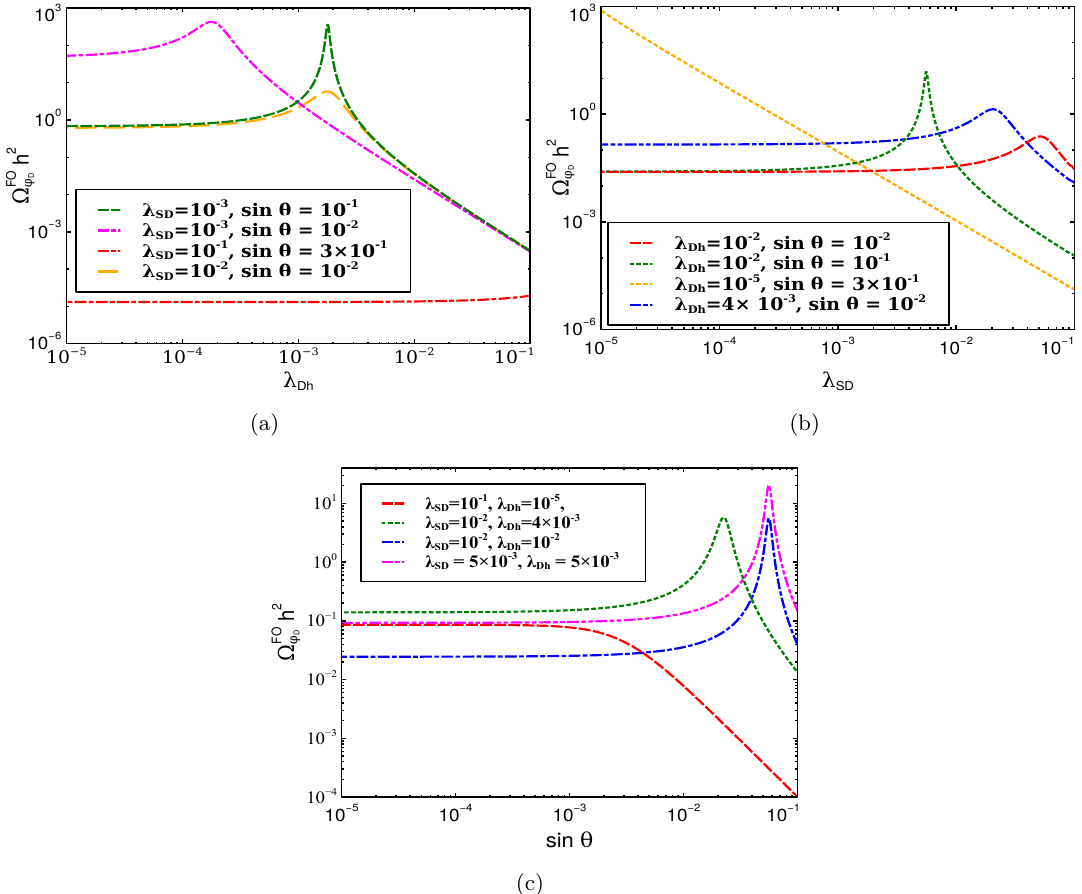
Figure 7 . Figure 7(a) and figure 7(b) show the variation of the relic abundance of φ D with the couplings λ and λ , respectively. Figure 7(c) shows the variation of relic abundance of φ DH SD with sin θ